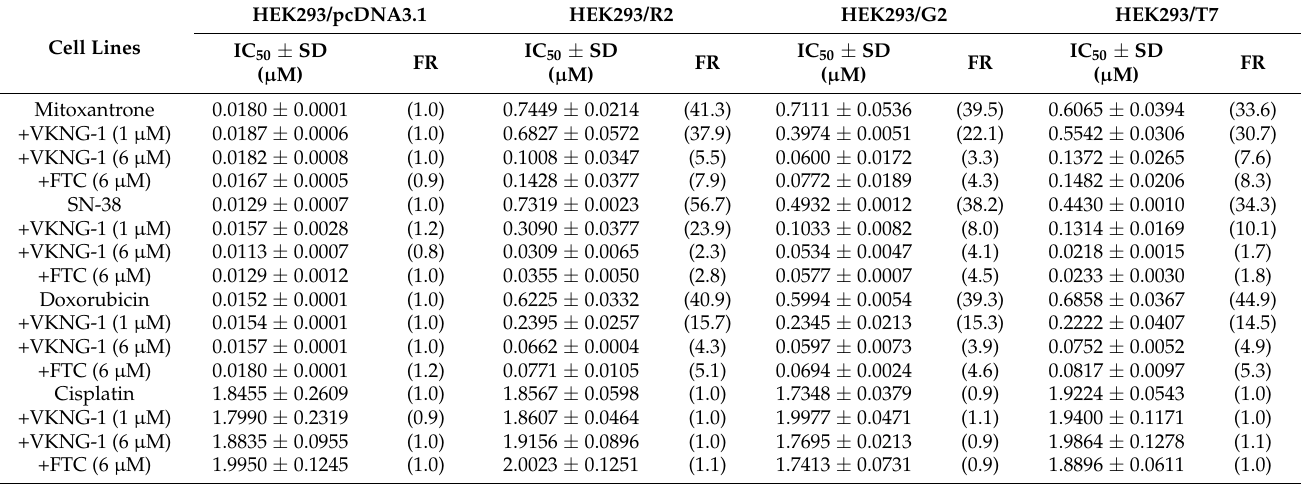
Table 2. The reversal effect of VKNG-1 on the cytotoxicity of anticancer drugs in ABCG2 transfected cell lines.